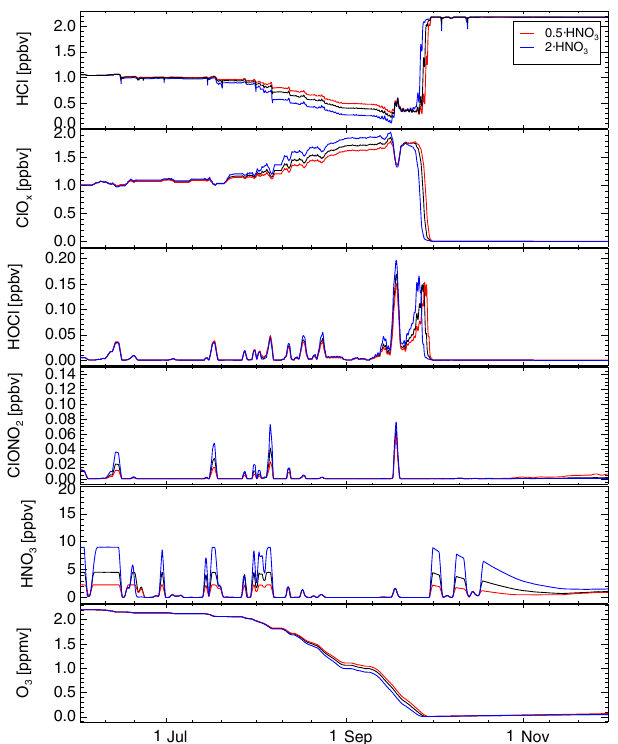
Figure A2. Simulation for the impact of denitrification. The impact of denitrification is tested by initialising the model run with HNO 3 doubled (blue line) and halved (red line). The black line shows the results of the reference